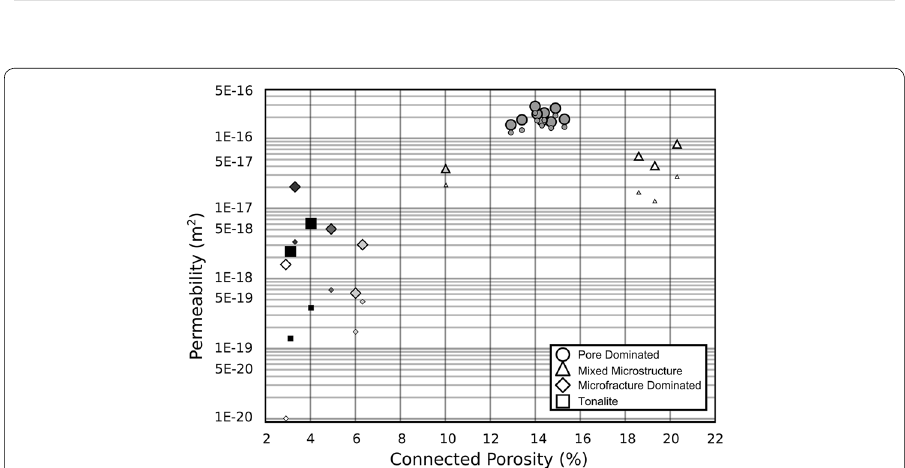
Fig. 11 Permeability versus connected porosity, showing permeability results from both 5 MPa (large symbols) and 55 MPa (small symbols) confining pressures. Tone darkens with depth of sample, as shown in legend in Fig. 7a